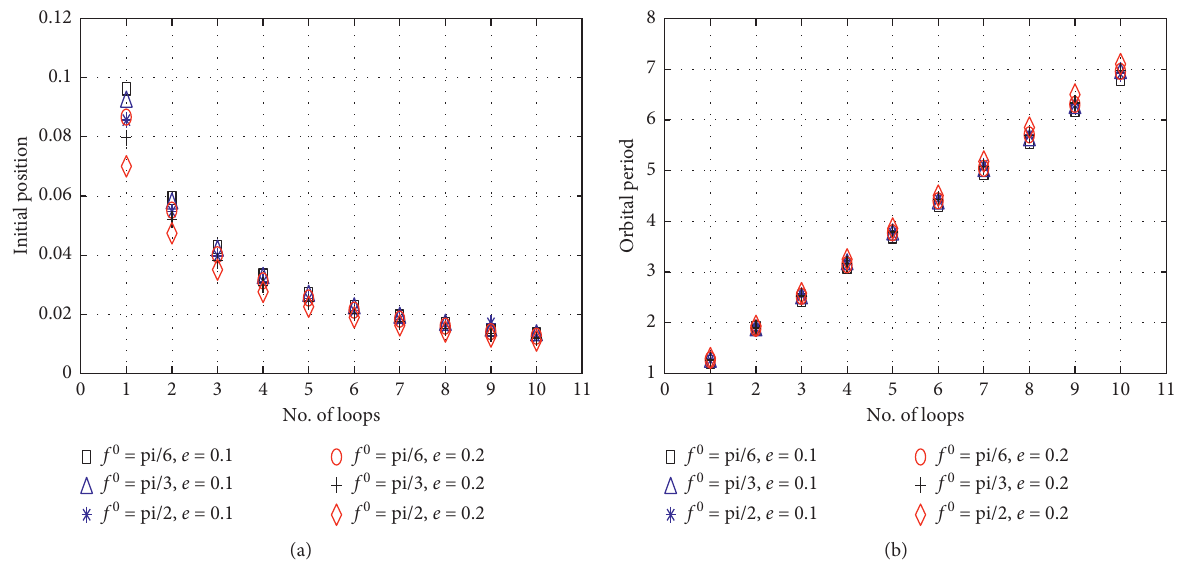
Figure 12: Variation in the (a) initial position of periodic orbits and (b) orbital period when _ y 0 � 0 .